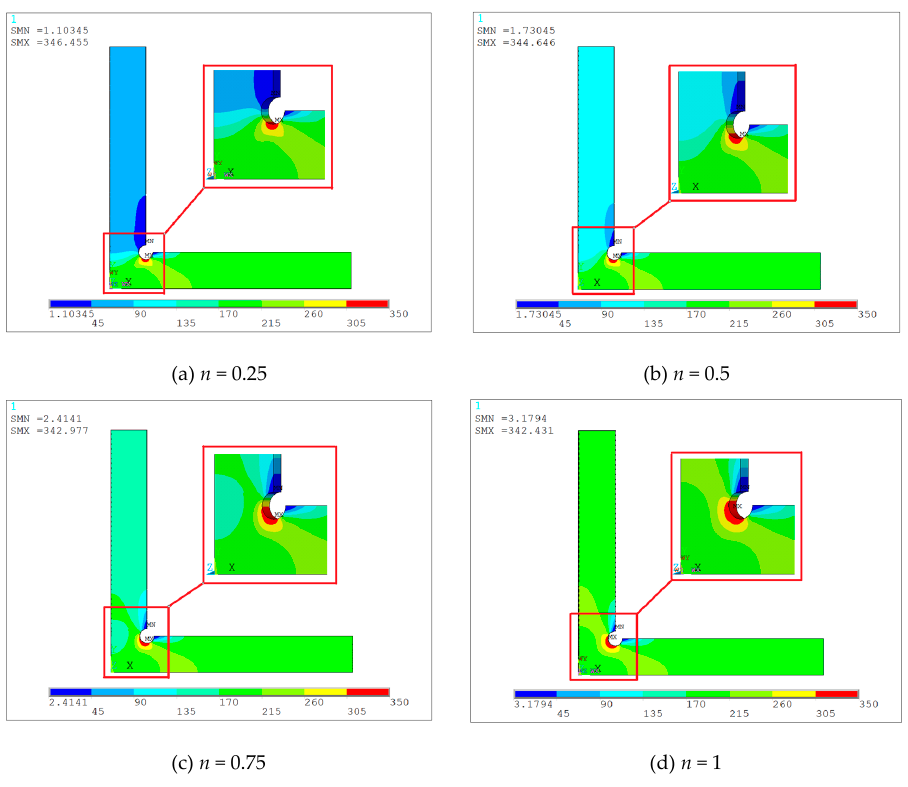
Figure 8. Mises stress distribution varying with n in specimen type D ( σ 0 = 200 MPa).